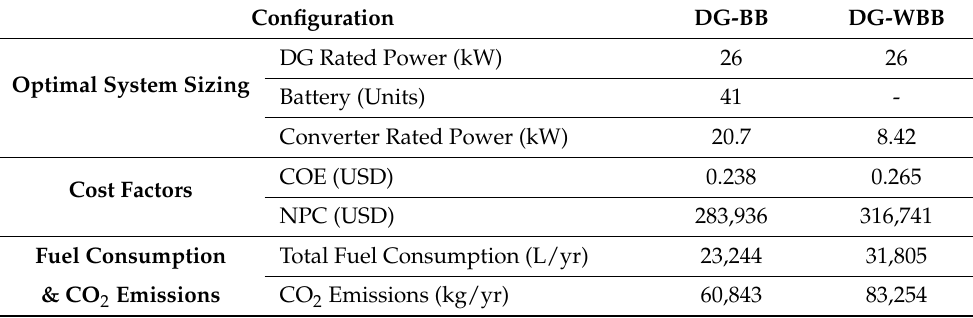
Table 14. Simulation Results for Jal-Alayah—DG-BB and DG-WBB